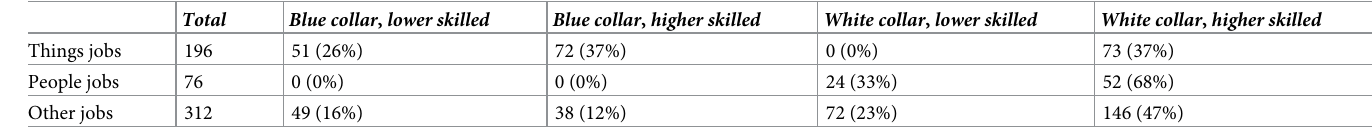
Table 1. Classification of 584 occupational categories derived from the ISCO categories available in the sample. For each of the three categories (things, people, other), we further list how many occupations fall in the blue/white collar and lower/higher skilled categories. Percentages are based on row totals.